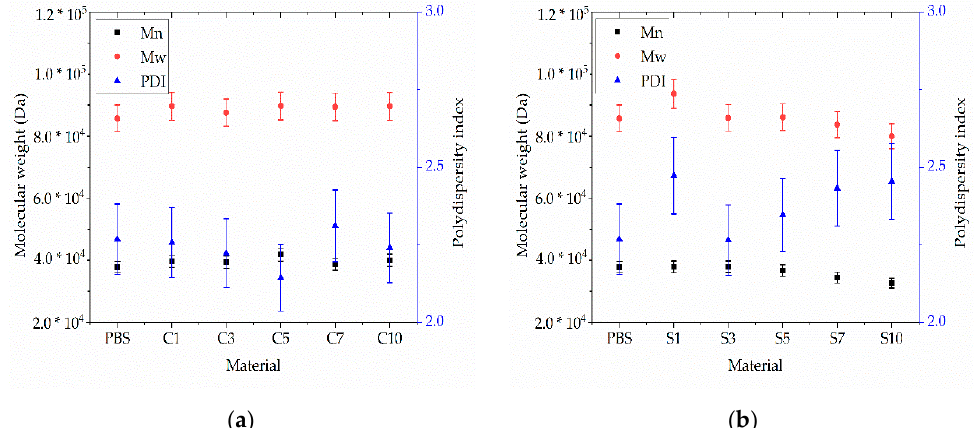
Figure 10. Weight average relative molecular weight (Mw), number average molar mass (Mn) and polydispersity index (PDI) of ( a ) PBS-curcumin compounds and ( b ) PBS-silver compounds. Data are means ± standard deviations ( n = 3).